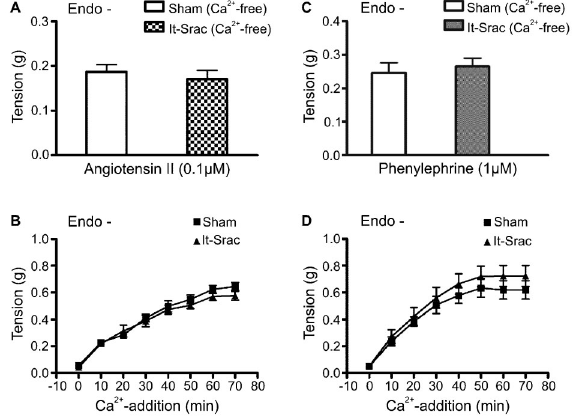
Figure 4. Transient and tonic contractions induced by angioten- sin II and phenylephrine in rat thoracic aortas under pressure overload. Transient contractile responses to angiotensin II ( A ) and phenylephrine ( C ) were elicited in Ca 2++ -free medium, and the subsequent tonic contractions were evoked by the addition of normal Ca 2++ in the absence of angiotensin II ( B ) or phenyleph- rine ( D ) in endothelium-denuded aortic rings prepared from rats 8 weeks after suprarenal abdominal aortic coarctation (lt-Srac) or sham surgery (Sham). The increase in contractile tone induced by Ca 2++ restoration is represented as a function of time. Data are reported as means±SE in grams of developed force. (n=14-16). A and C , P not significant (unpaired Student t -test). B and D , P not significant (two-way